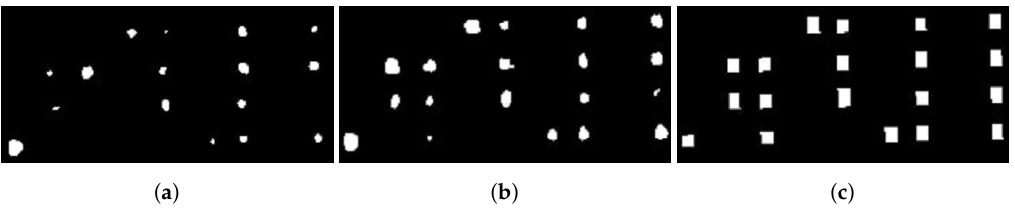
Figure 6. Detailed comparison of high vs. low resolution RGB information based on FCN4s network. ( a ) illustrates the results from LateConc-PAN&RGB&DSM-mrFCN4s network, ( b ) depicts the resulted mask from Fused-FCN4s model and ( c ) is a ground truth mask.